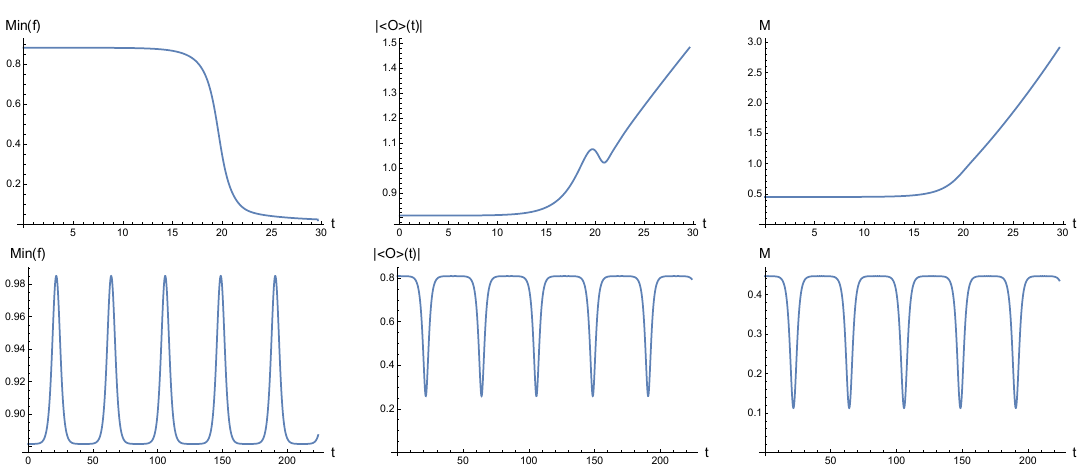
Figure 7 . Evolution of three magnitudes for an unstable SPS with (cid:26) b = 0 : 09, (cid:26) o = 0 : 56 and ! b = 2 after being perturbed with the (cid:12)rst unstable mode (cid:30) (0 ; x ) + (cid:15) 1 (cid:31) 1 ( x ). The upper (lower) three plots correspond to (cid:15) 1 = (cid:0) 10 (cid:0) 4 (+10 (cid:0) 4 ). The magnitudes shown are the minimum of the metric function min ( f ( t; x )), the energy density m , and the vev jhOij . A relaxation oscillation x 2 [0 ;(cid:25)= 2) with a pronounced peak and a long lived plateau is apparent on the lower